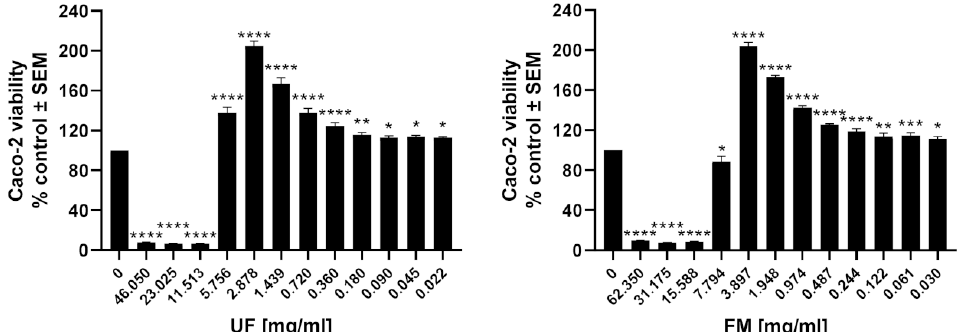
Figure 4. Effect of tested samples on Caco-2 cell proliferation. Cells were treated with different concentrations of tested samples for 24 h, and proliferation was assessed using PrestoBlue™ Cell Viability Reagent. The data are presented as the mean ± SEM. Statistical significance in comparison to the negative control (untreated cells) was assessed using one-way ANOVA followed by Dunnett’s multiple comparison test; * p < 0.05; ** p < 0.01; *** p < 0.001; **** p <